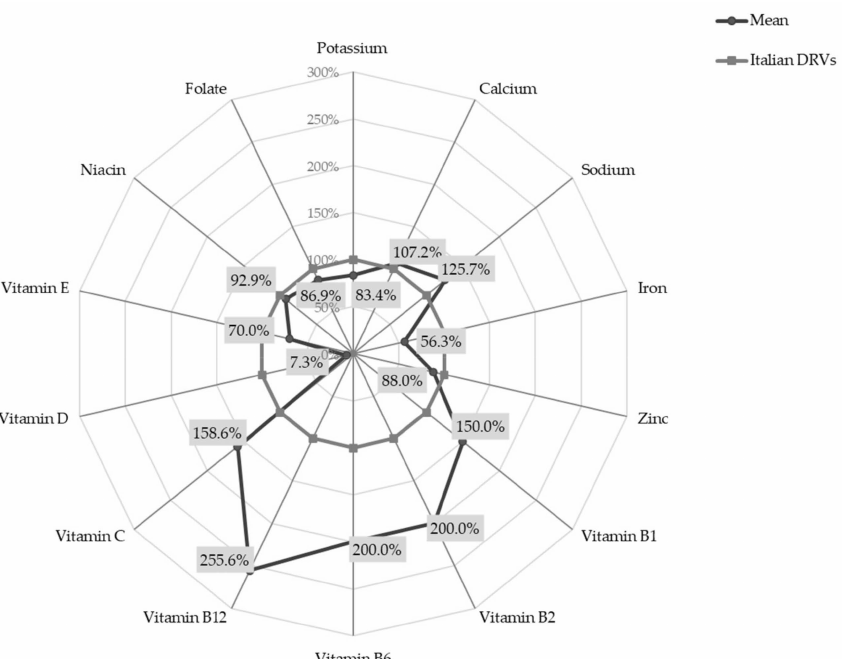
Figure 1. Micronutrient intakes in infants at 18 months of age, expressed as percentage deviation from Italian DRVs (PRI and AI) ( n = 389). Abbreviation: DRVs, dietary reference values. A statistically significant difference between females and males was observed for the intake of vitamin B12 (females 2.4 ± 1.1 µ g/day vs. males 2.2 ± 1.1 µ g/day; p -value < 0.05).